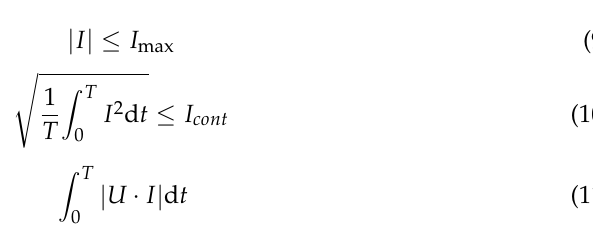
Table 3. Parameters used in the simulation. U max and I max are the capacity of Escon 50/5. J p is the inertia of VIVOIL reversable pump. η was selected based on experience.